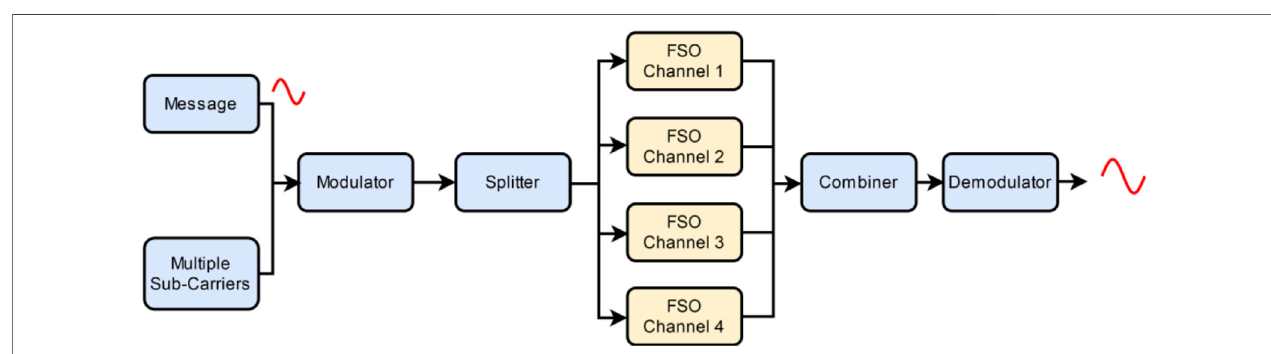
FIGURE 3 | Block diagram of an FSO MIMO system with multiple